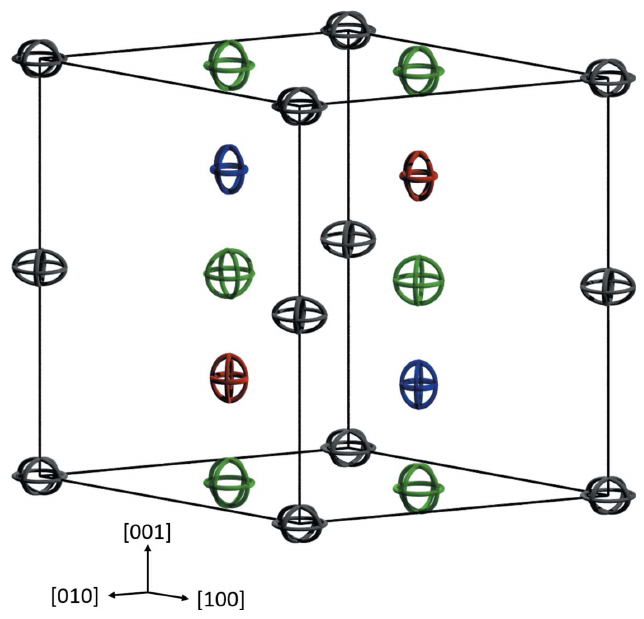
Figure 1 Representation of the unit cell of quaternary (Sn,Pb,Bi)Pt. Color code: Grey – Pt1; red – Sn1, Pb1, Bi1; blue – Sn2; green – Sn3. Displacement ellipsoids are drawn at the 95% probability